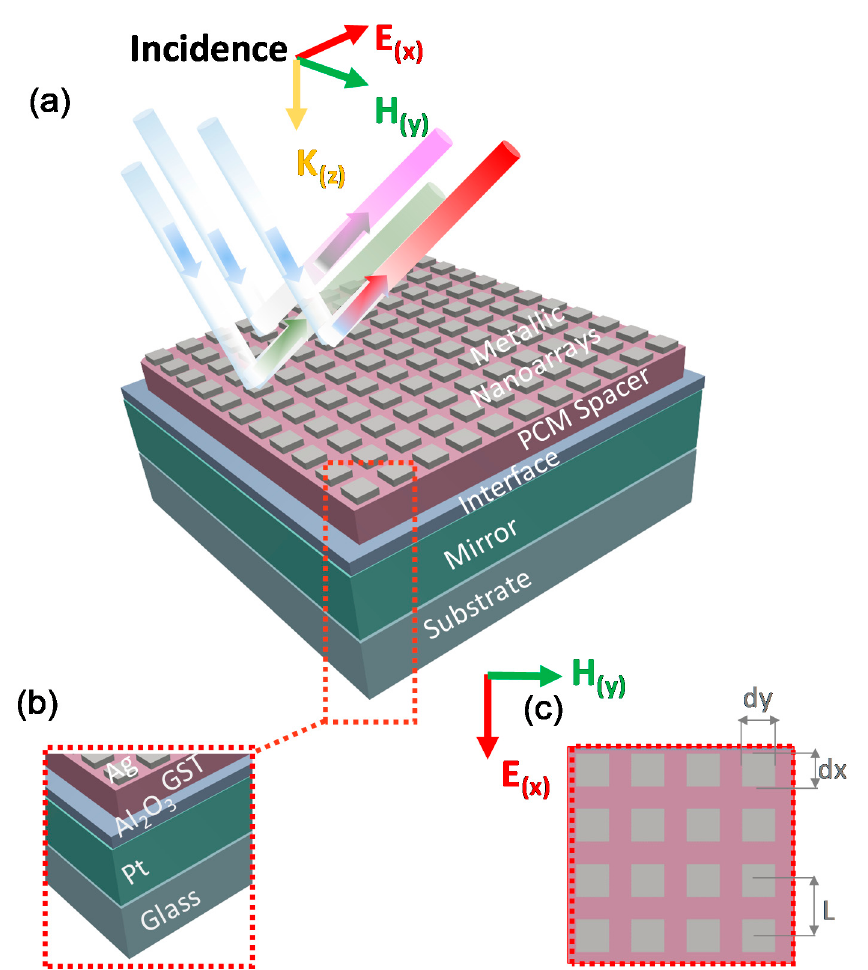
Figure 1. ( a ) Illustration of the reconfigurable and programmable metamaterial perfect absorber (RPMPA) and resistive switching memory (ReRAM) structures, including the incident light polarization conformation. Glass (silica) was selected as a substrate with a thickness of 250 µ m. ( b ) Schematic of a unit cell of the RPMPA and ReRAM with an Ag/Ge 2 Sb 2 Te 5 (GST)/Al 2 O 3 /Pt/SiO 2 structure. ( c ) Top view of the RPMPA and ReRAM, and the Ag nanosquares with d x and d y dimensions and chips of L (the middle to middle distance between the patterned squares).